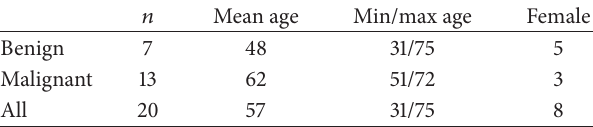
Table 1: Characteristics of the study